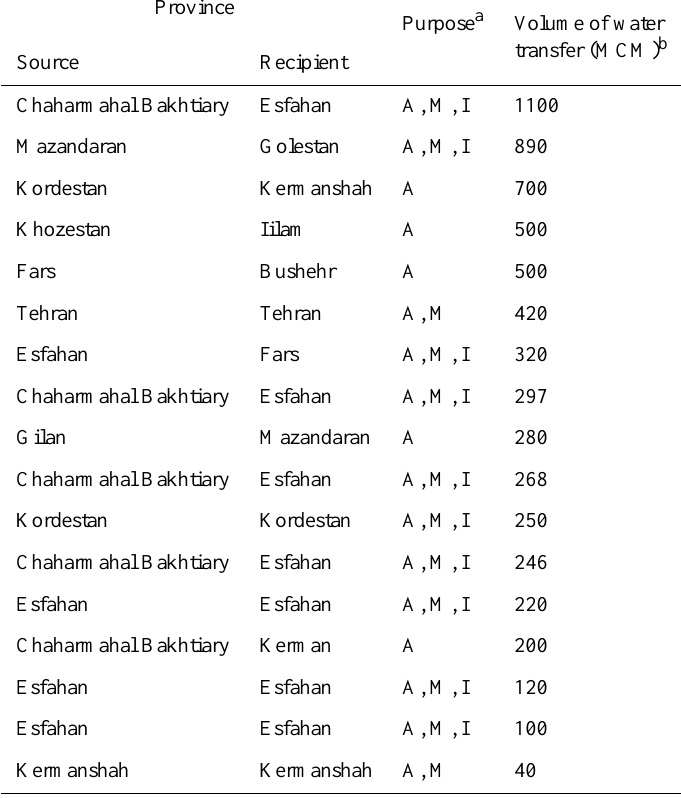
Table 5. Major inter-basin water transfer projects in